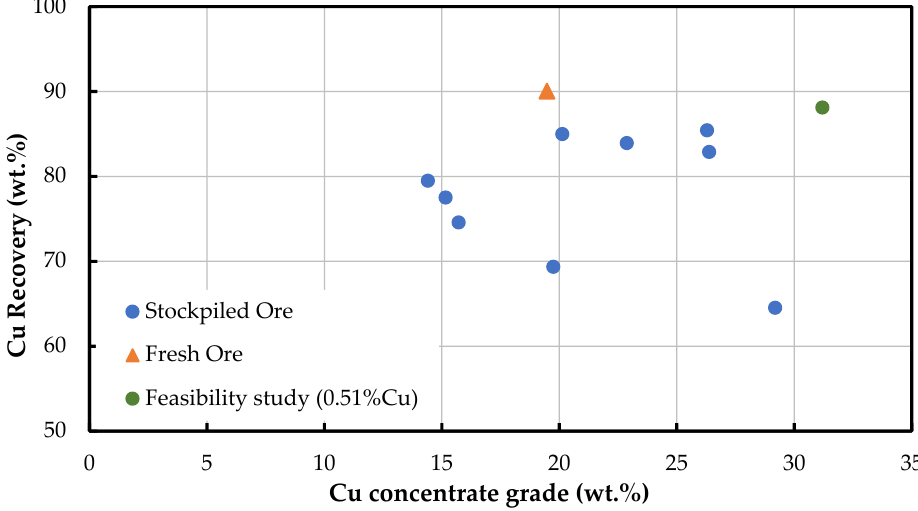
Figure 23. Copper recovery versus copper concentrate grate from the locked-cycle tests.